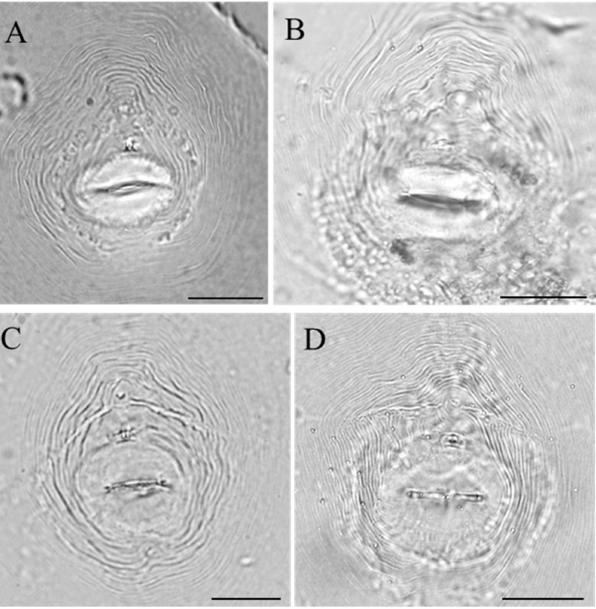
Figure 2. Perineal patterns of M. enterolobii ( A , B ) and M. javanica ( C , D ), obtained from females extracted from collected roots of dragon fruit plants (scale bar = 20 µ m).